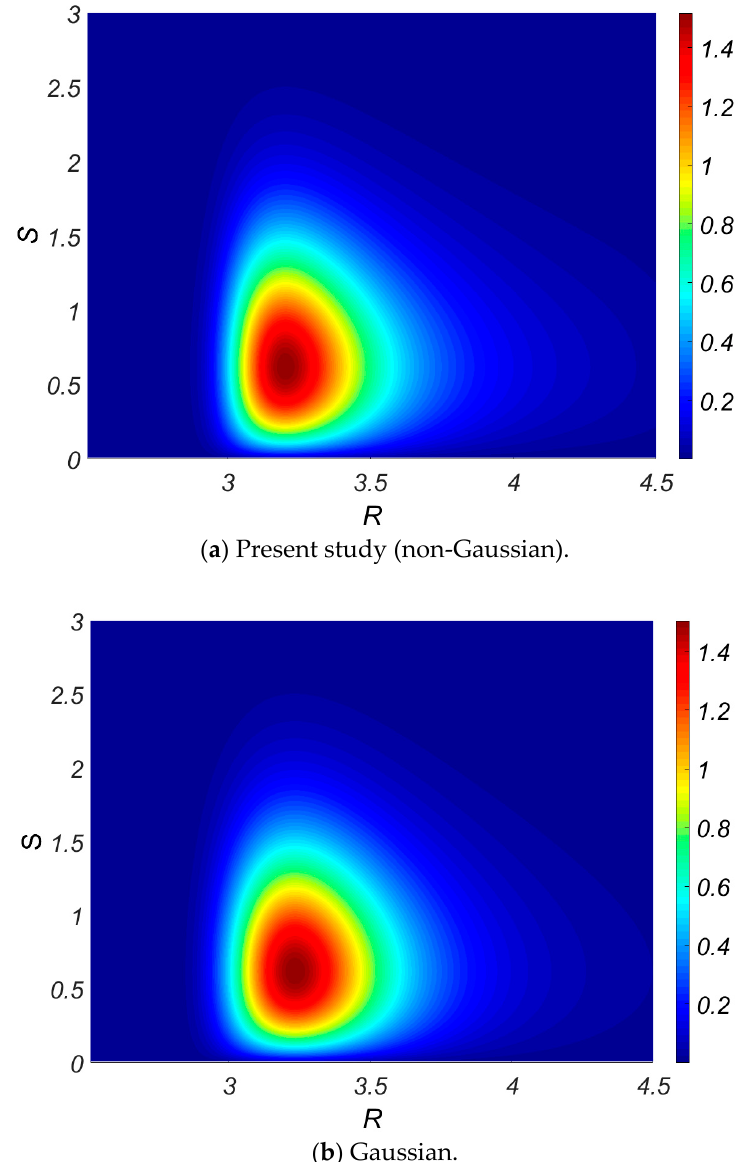
Figure 17. Joint probability density function of R and S based on the wave slope distribution proposed in this study [ D n = 2.3 m , ν =